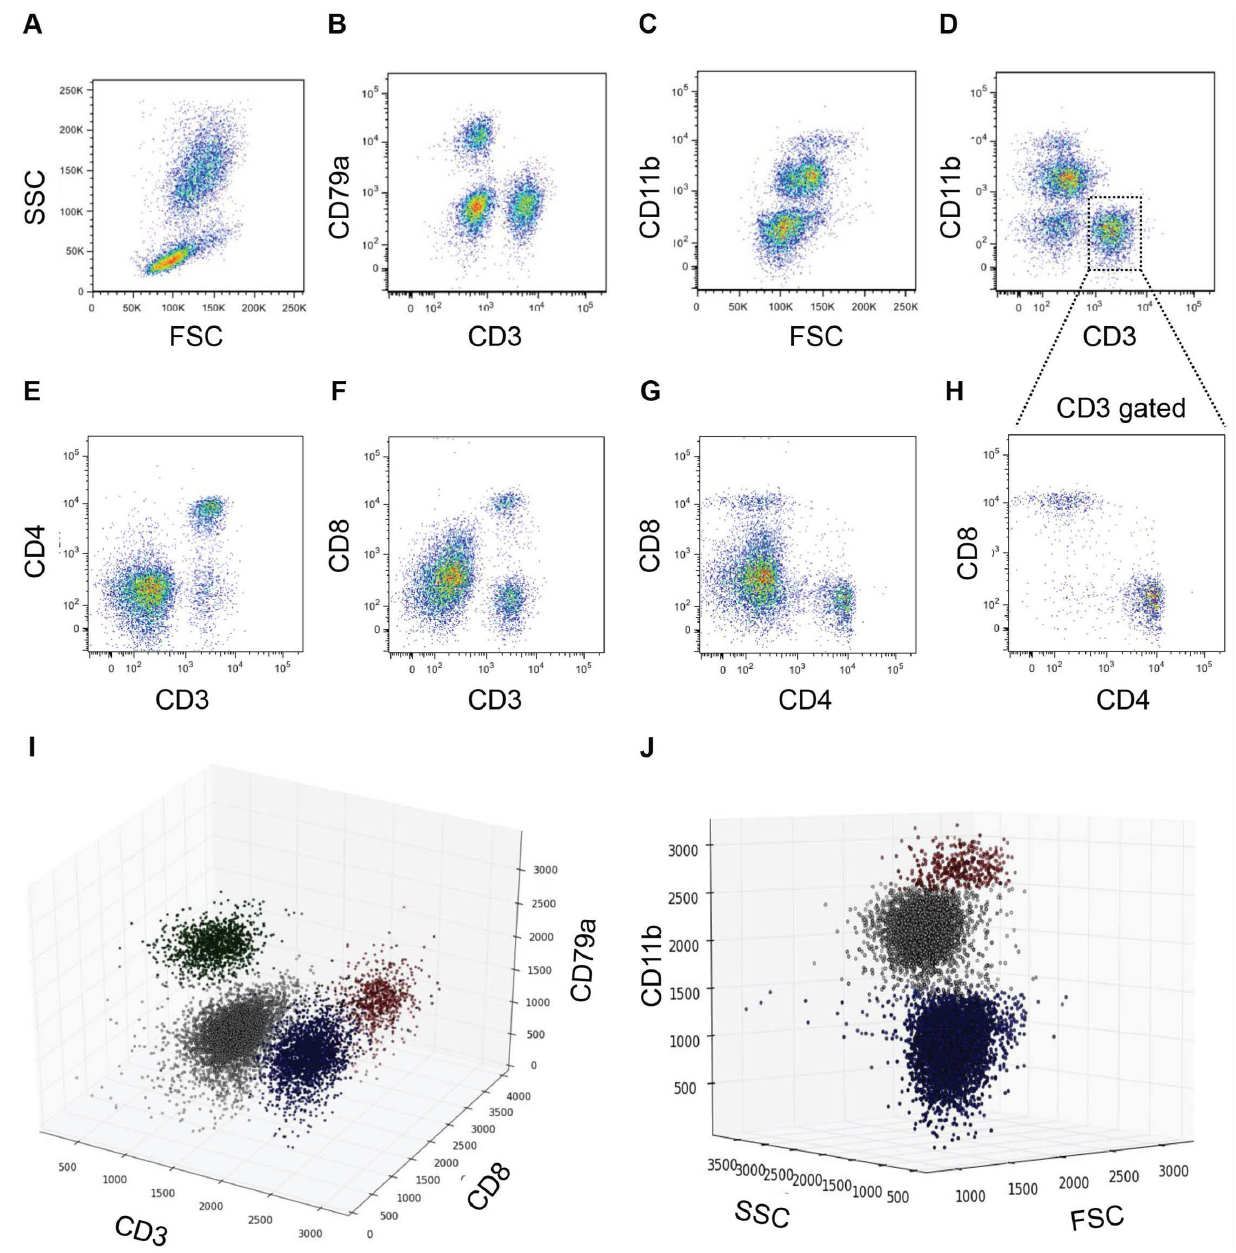
Figure 1. Flow cytometry of ferret peripheral blood leukocytes. Representative stains for ( A ) unstained, unpermeablized cells after gating out doublets; ( B ) CD3 vs CD79a; ( C ) CD11b; ( D ) CD3 vs CD11b; ( E ) CD3 vs CD4; ( F ) CD3 vs CD8; ( G ) CD4 vs CD8 (ungated cells); ( H ) CD4 vs CD8 (CD3 gated cells); ( I ) CD3 vs CD8 vs CD79a (B cells: Green; CD8 + ve T cells: Red; CD8-ve T cells: Blue; Granulocytes/NK cells/Monocytes/DC: Gray); ( J ) FSC vs SSC vs CD11b (Monocytes/DC: Red; Lymphocytes: Blue; Granulocytes: